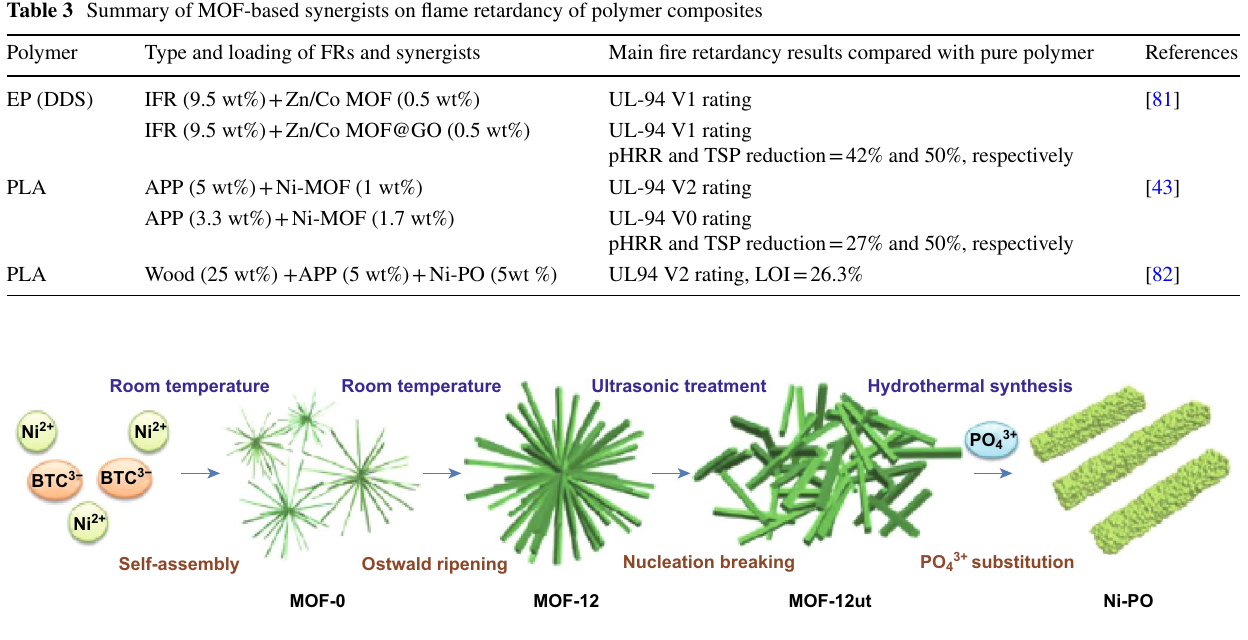
Fig. 19 Schematic illustration of the formation from Ni‑MOF to Ni‑PO. Reproduced from Ref. [82] with permission from American Chemical Society